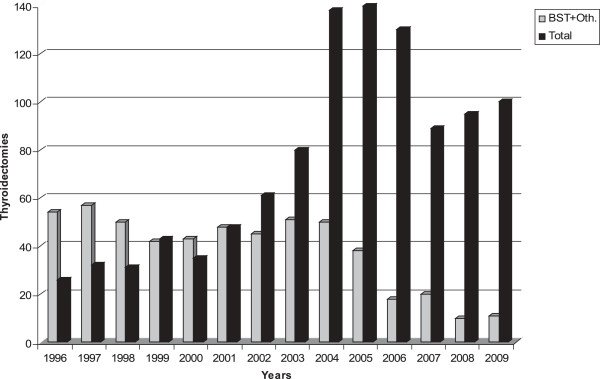
Annual changes of thyroidectomy techniques. Oth: Other.